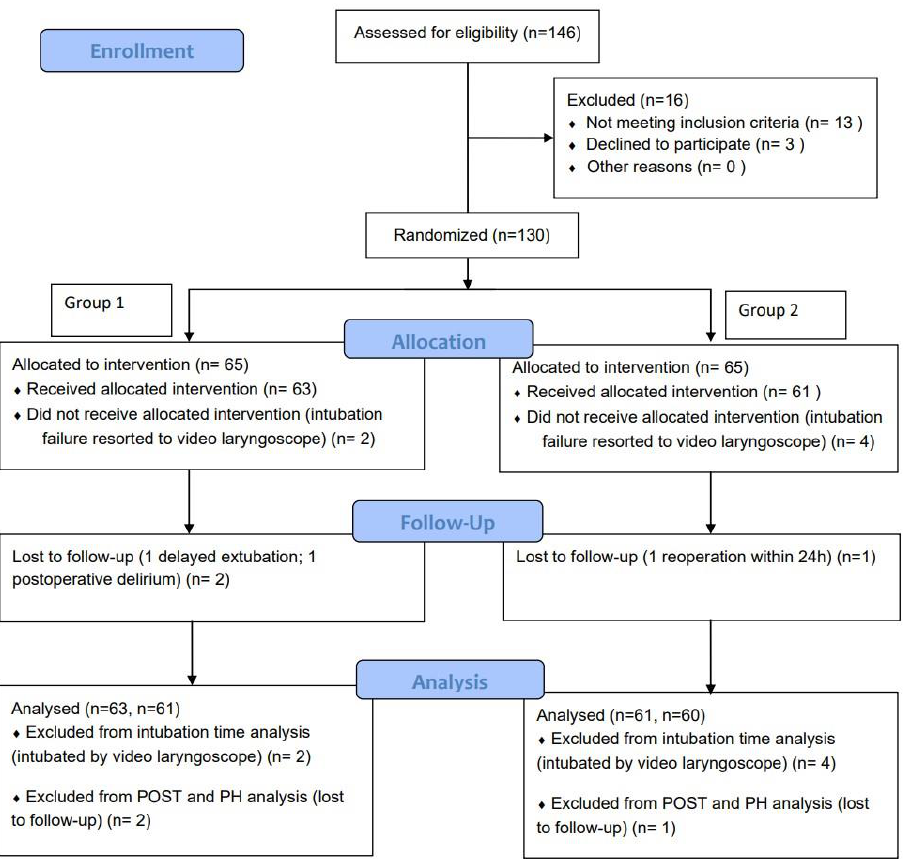
Figure 2. CONSORT diagram of this trial. Abbreviations: CONSORT, Consolidated Standards of Reporting Trials; POST, postoperative sore throat; PH, postoperative hoarseness. Table 1. Demographic and perioperative data.